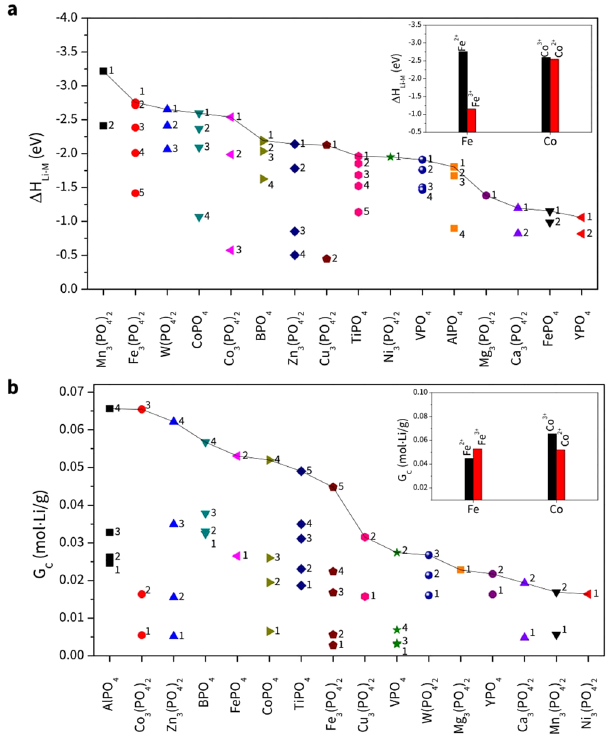
Figure 2. The descending orders of ( a ) Δ H Li-M and ( b ) G C , and (inset) comparison between materials having the same metal element for the reaction between metal phosphate and Li 2 O. Each number in ( a ) and ( b ) denotes the reaction equation